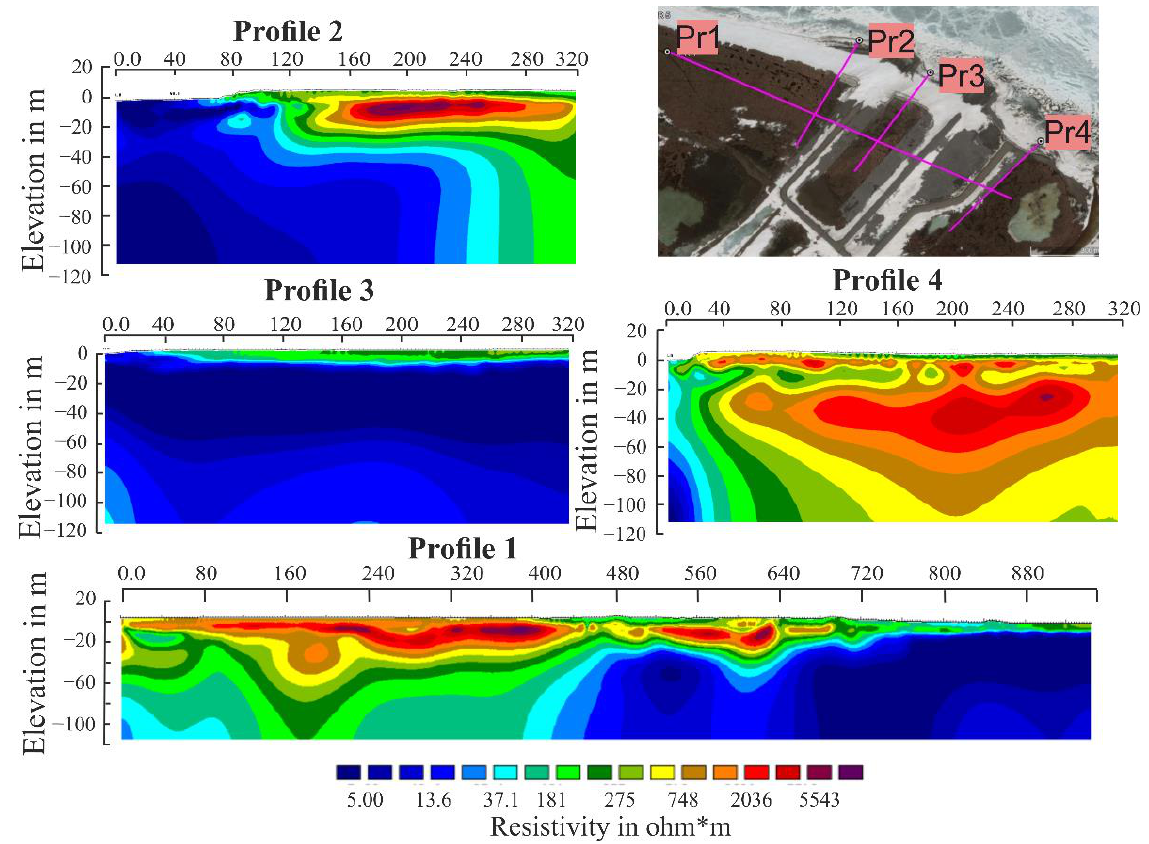
Figure 10. Results of ERT images in the Baydaratskaya Bay area: Profile #1; Profile #2; Profile #3; Profile #4 and lines of Profiles #1 – 4 (satellite image from [28]).